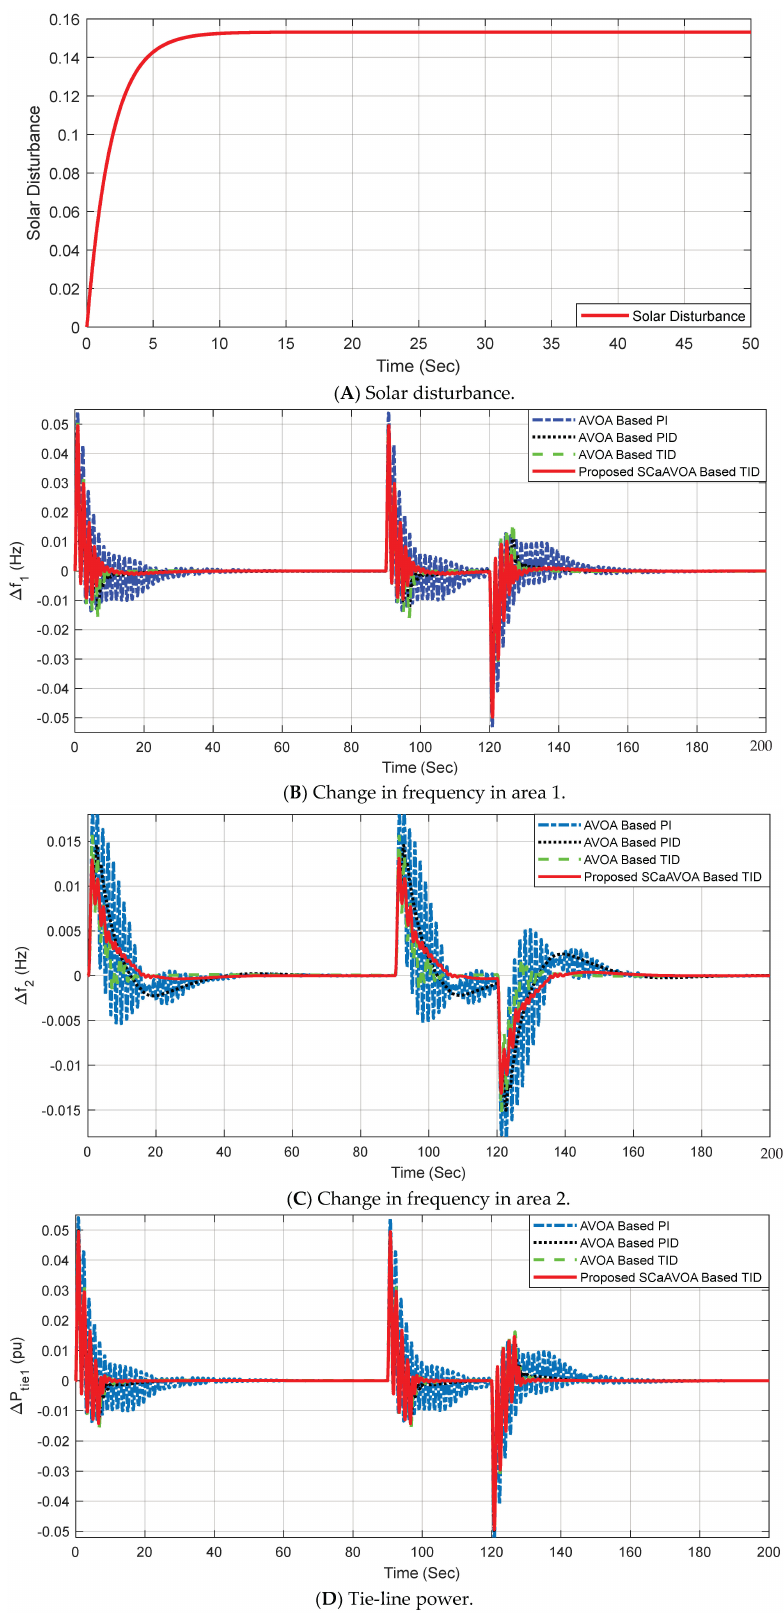
Figure 5. ( A – D ) System response for the five-area, ten-unit system with solar